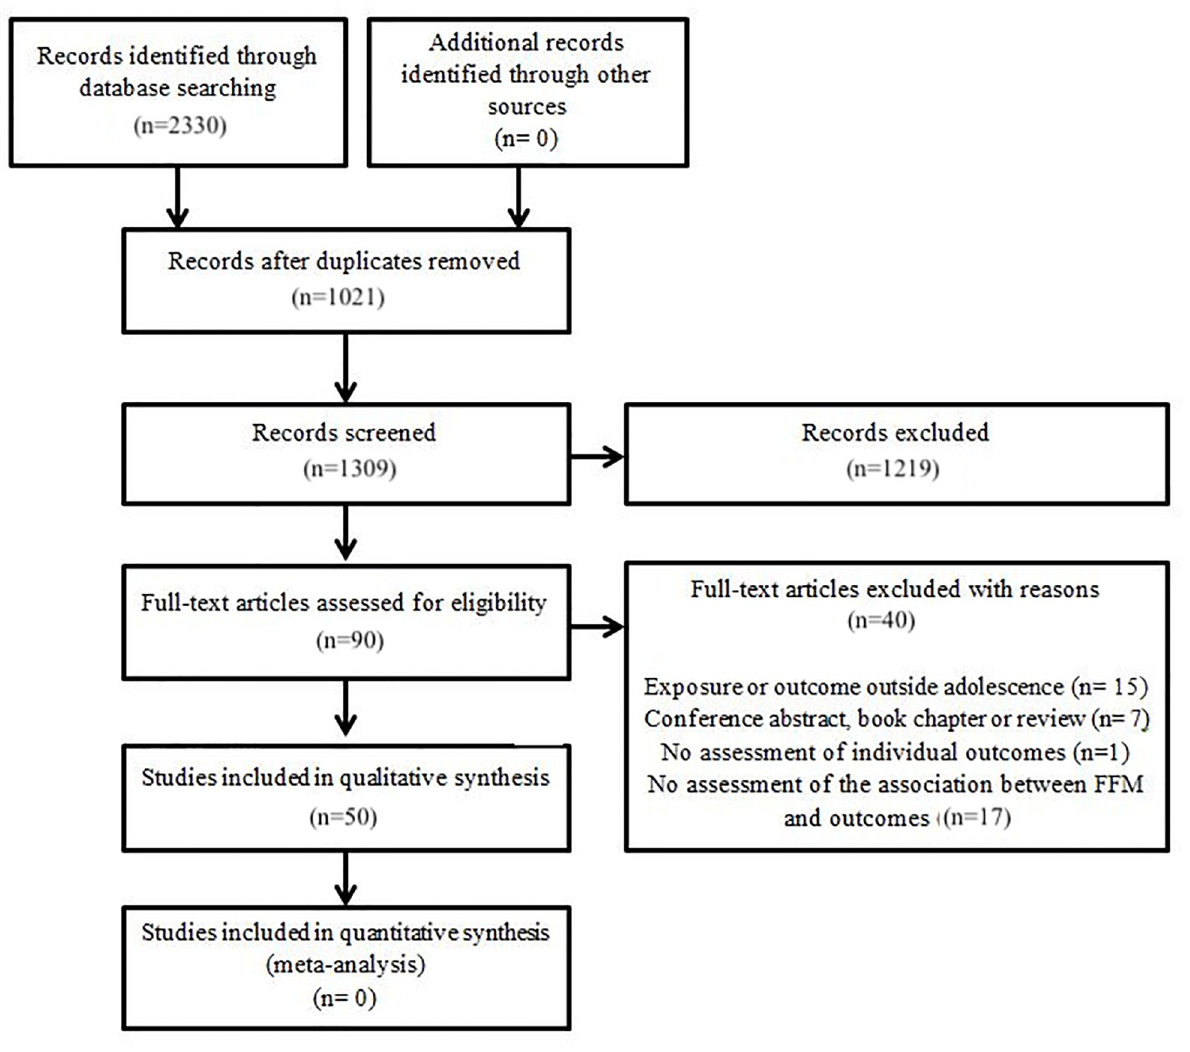
Fig 2. Study selection